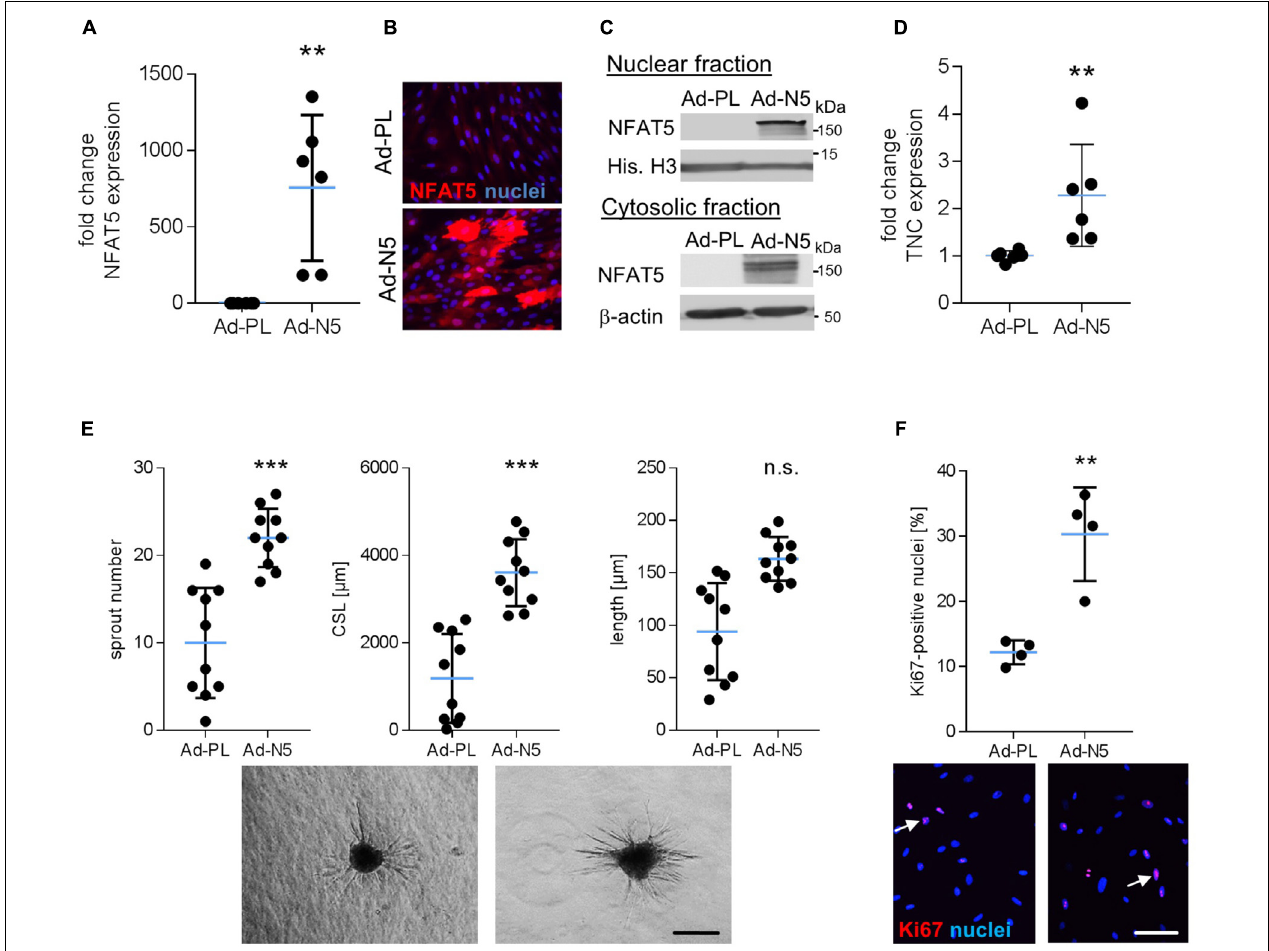
FIGURE 6 | Overexpression of NFAT5c promotes its nuclear accumulation and activates VSMCs. HUASMCs were transduced with adenovirus to overexpress NFAT5c (Ad-N5) or (Ad-PL) control plasmid, N FAT5 -expression was quantitated by qRT-PCR, immunostaining and immunoblot of nuclear and cytosolic lysates 48 h after transfection ( A–C , ∗∗ p < 0.01 vs. Ad-PL, n = 6, unpaired, 2-tailed Student’s t -test; histone H3 and β -actin served as loading controls). Expression levels of NFAT5 target gene TNC was assessed by qRT-PCR ( D , ∗∗ p < 0.01 vs. Ad-PL, n = 6, unpaired, 2-tailed Student’s t -test). The migratory capacity of collagen-embedded NFAT5c -overexpressing spheroids was analyzed by assessing the number of sprouts, mean sprout length and cumulative sprout length after 24 h ( E , ∗∗∗ p < 0.001 vs. Ad-PL, n = 10 spheroids/condition, 1 out of 3 independent experiments with comparable results, unpaired, 2-tailed Student’s t -test; scale bar: 200 µ m). Proliferation of NFAT5c-overexpressing HUASMCs 72 h after transfection by immunostaining of the proliferation marker Ki67 ( F , ∗ p < 0.05, n.s.: not significant, vs. Ad-PL, n = 4, unpaired, 2-tailed Student’s t -test, scale bar: 100 µ